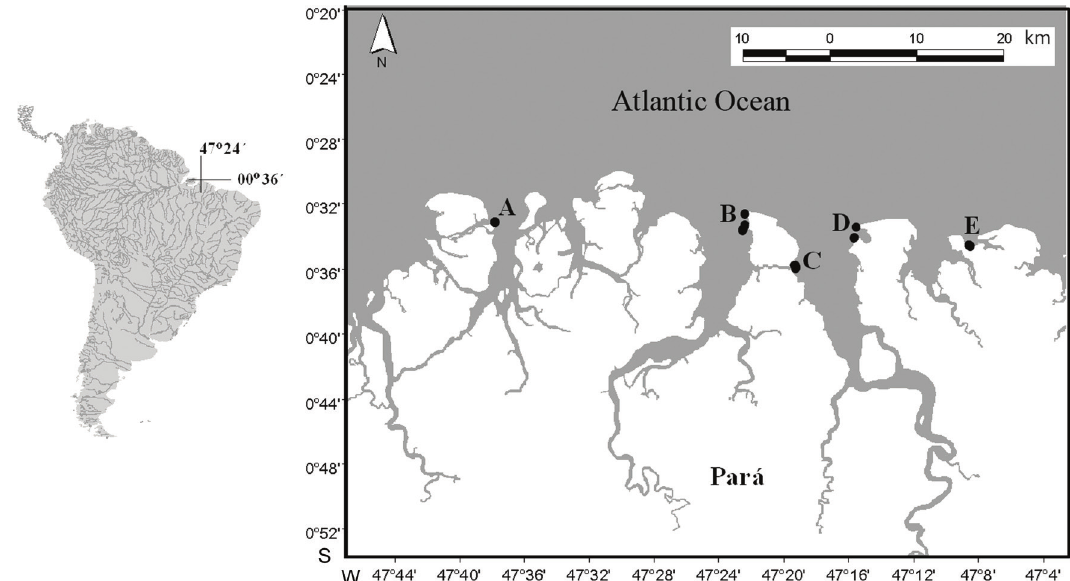
Fig. 1. Location of the tide pools sampled in 2011 on the sandy beaches of the Amazonian Coastal Zone at (A) Areuá, (B) Algodoal, (C) Fortalezinha, (D) Marieta, and (E)